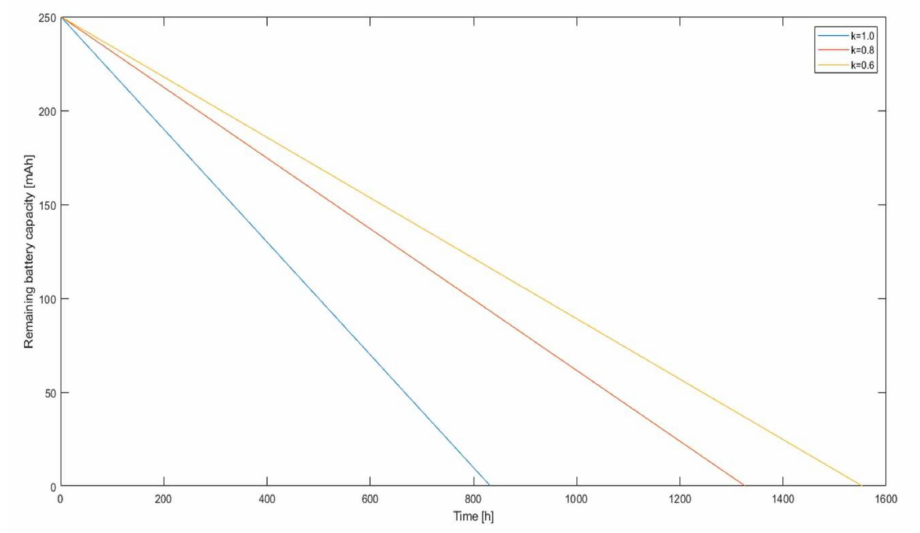
Figure 15. Battery charge remaining as a function of time for different k -factor